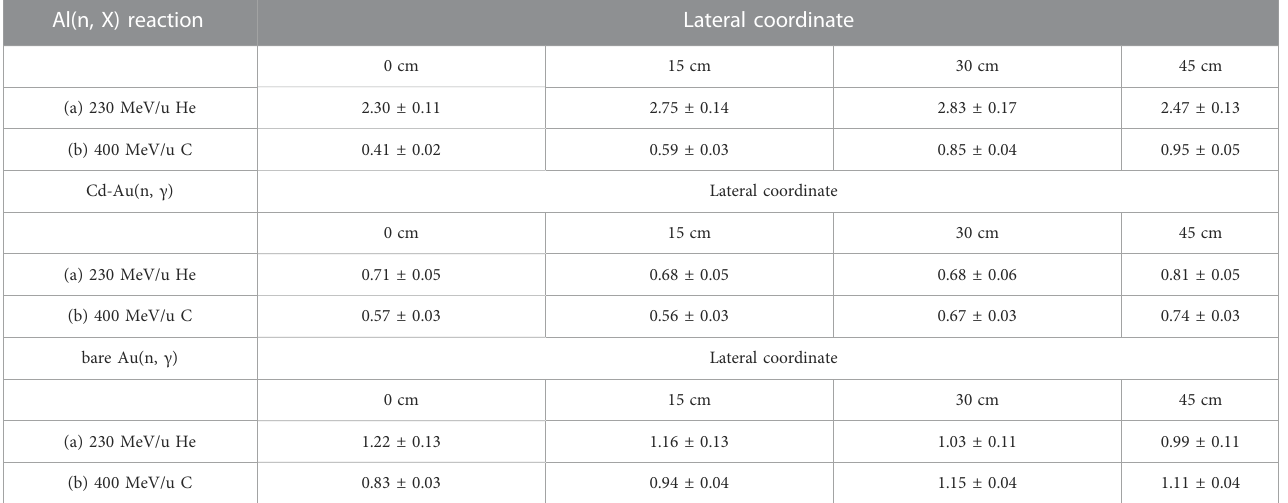
TABLE 5 C/E with one standard deviation for Al(n, X), Cd-Au(n, γ ), and bare Au(n, γ ) reaction rates at 60 cm of depth. The experimental errors include one standard deviation based on an uncertainty analysis. Al(n, X) reaction Lateral